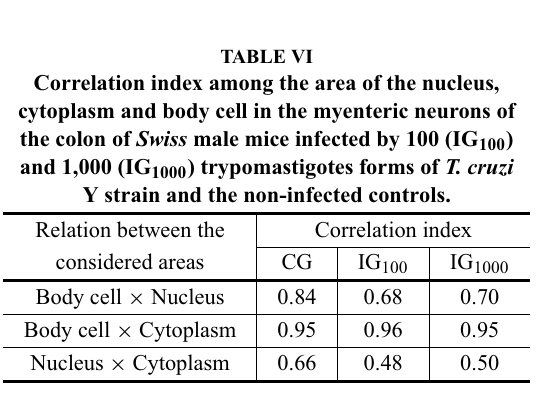
Values followed by different letters in the same line express statistically significant differences (p < 0.05).